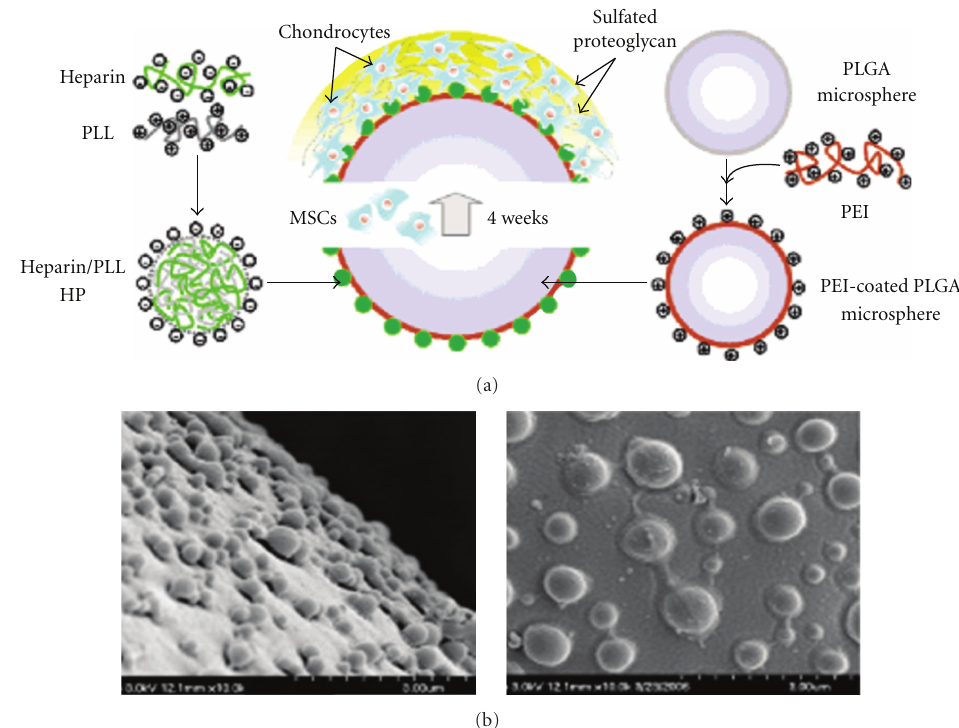
Figure 2: (a) Diagram of heparinized nanoparticles coated onto PLGA microsphere for stem cell delivery. (b) The SEM images of PLGA microspheres (upper (left) and bottom (right)) fabricated with heparin/poly(l-lysine) nanoparticles